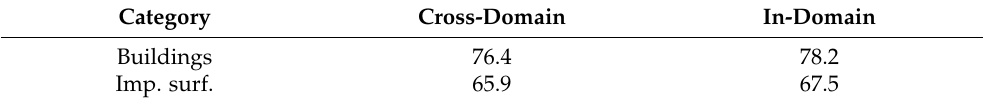
Table 8. F1 score of building and impervious surface on cross-domain and in-domain transfer.